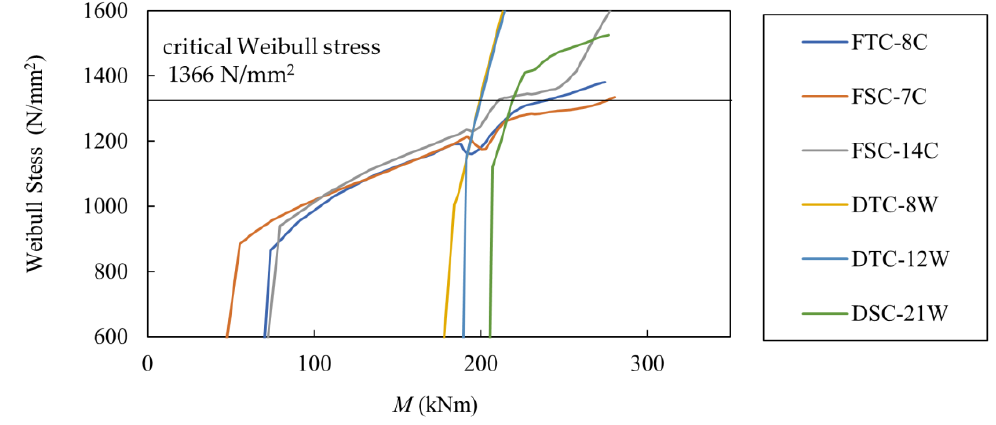
Figure 12. Weibull stress vs. moment curves.